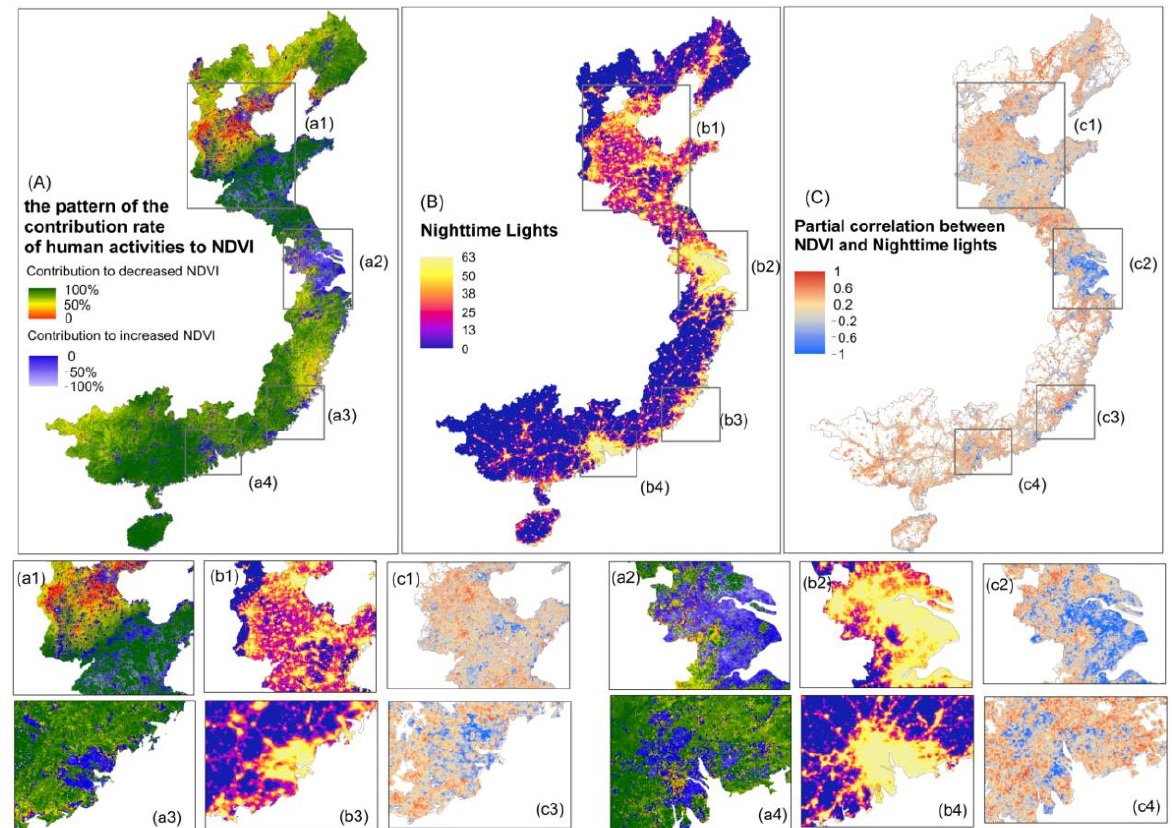
Figure 7. Validation for residual trend analysis. ( A ) The spatial pattern of the contribution rate of human activities to NDVI separated by the residual trend analysis; ( B ) the spatial pattern of the average annual nighttime light from 2000 to 2013; and ( C ) the partial correlation coefficient between NDVI and nighttime lights by excluding the effect of precipitation and temperature. ( a1 – a4 ) repre ‐ sent the Beijing–Tianjin–Hebei urban agglomeration, the Yangtze River Delta, the Fuzhou–Xiamen– Quanzhou urban agglomeration, and the Pearl River Delta region, respectively. ( b1 – b4 ) and ( c1 – c4 ) circles the consistent regions.